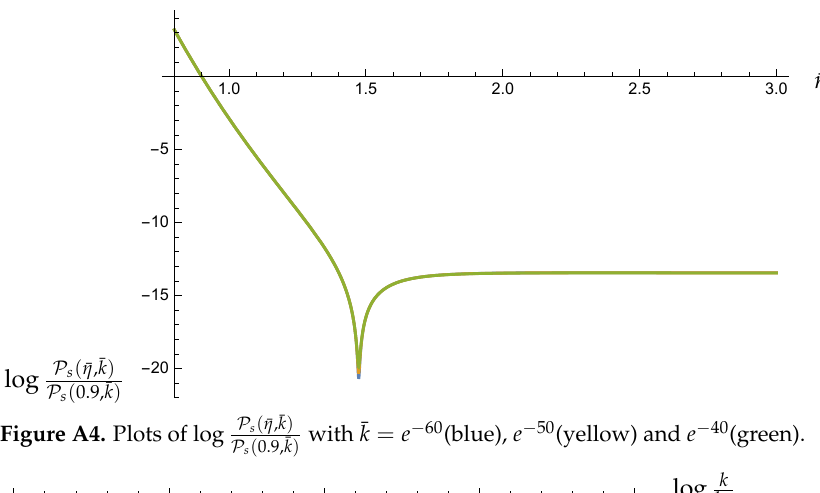
Figure A4. Plots of log P s ( ¯ η